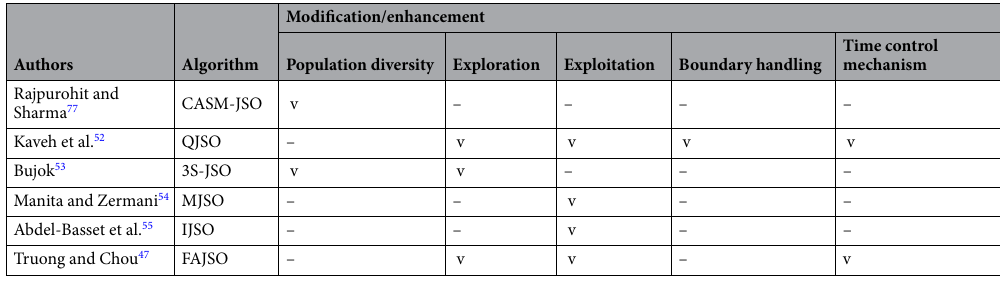
Table 1. Enhancements of